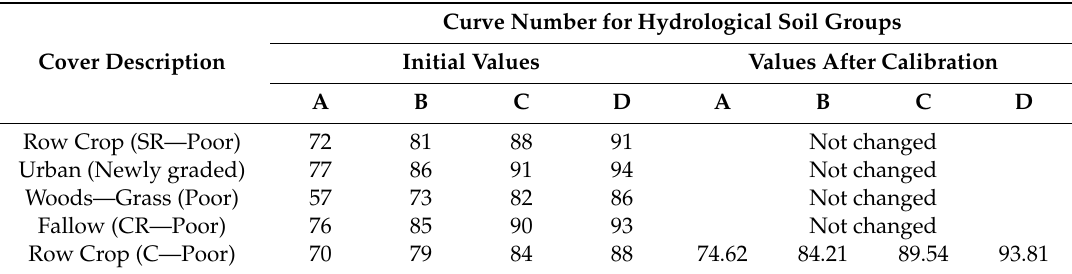
Table 2. Curve Numbers (CN) used for model calibration, Fall Creek watershed.